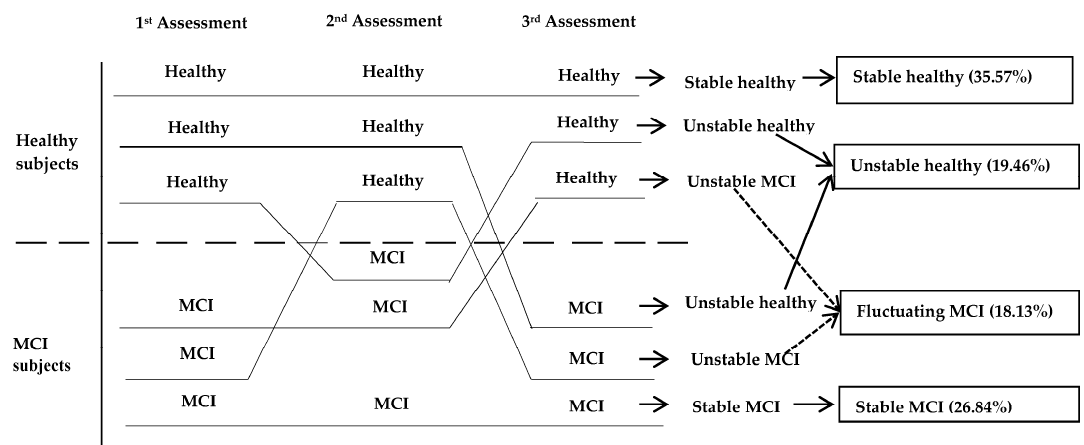
Figure 1. Heterogeneity of the cognitive trajectories in cognitively healthy older adults and MCI subjects in a year ‐ year follow ‐ up study. Doctoral Thesis, García ‐ Herranz [39].